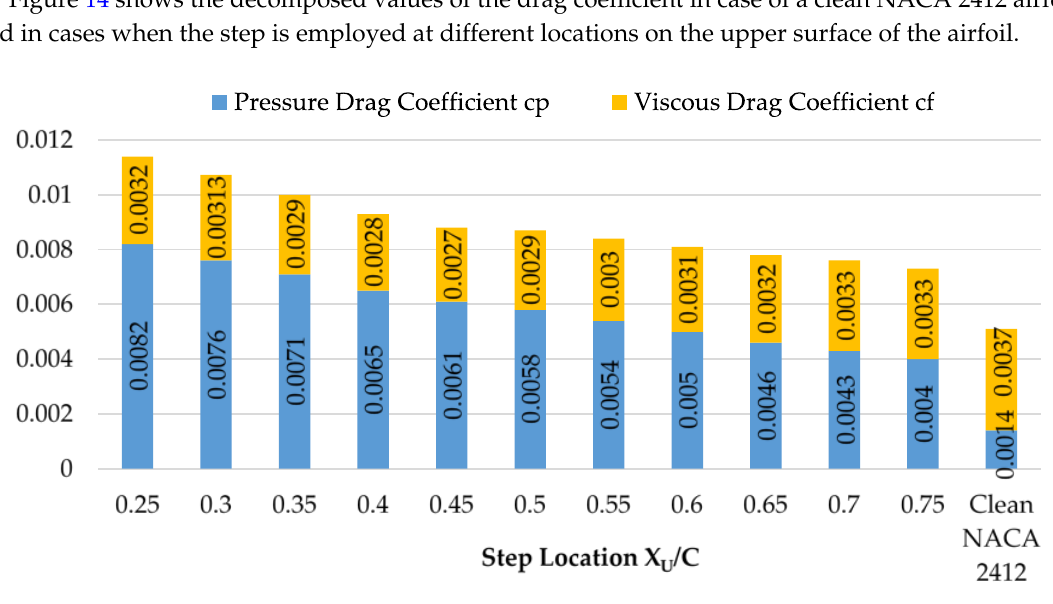
Figure 14. Decomposition of the drag coefficient to pressure drag and viscous drag coefficients.